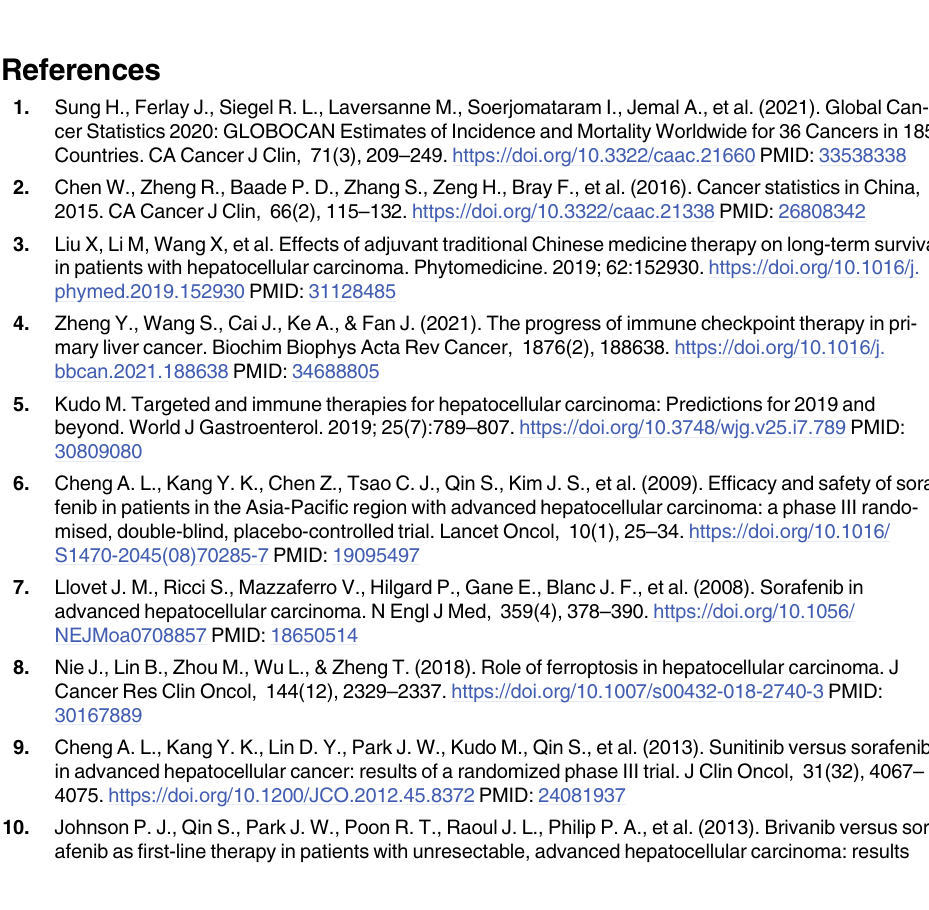
S1 Table. The original data of the network meta. S2 Table. Key model